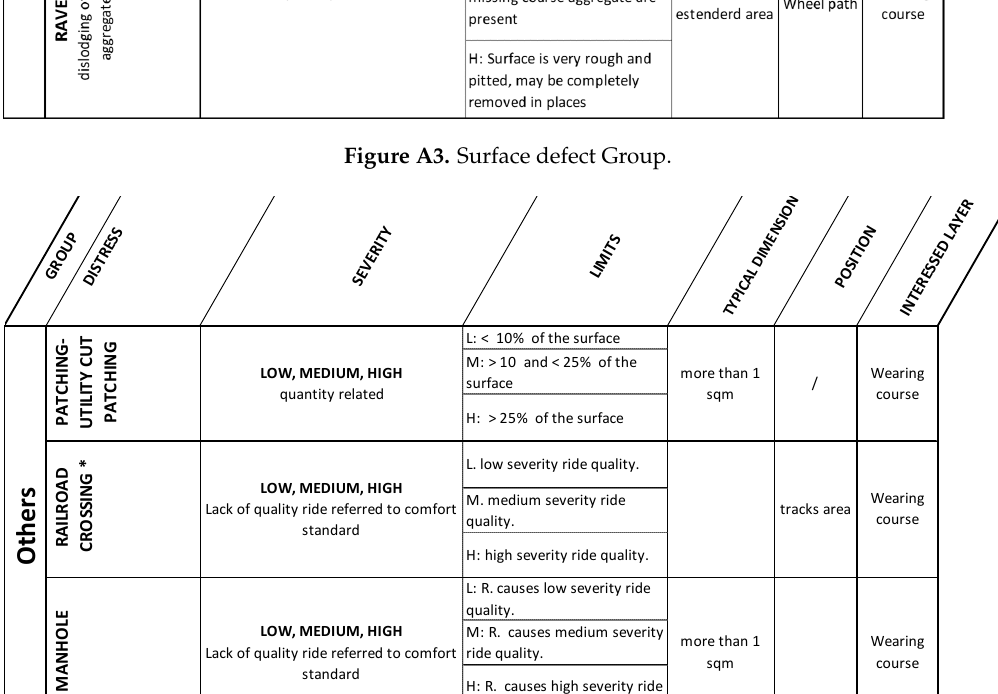
Infrastructures 2018 , 3 , x FOR PEER REVIEW